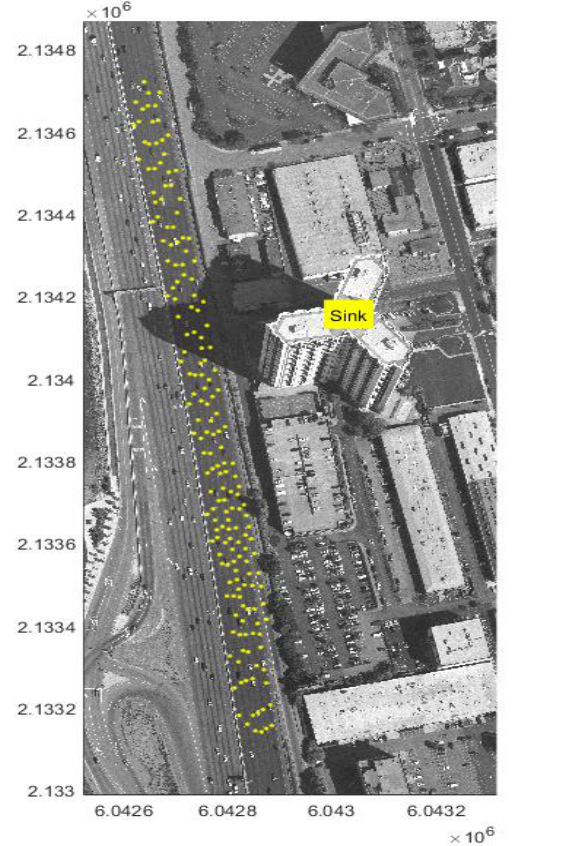
Figure 1. The location of vehicular sensors and the sink